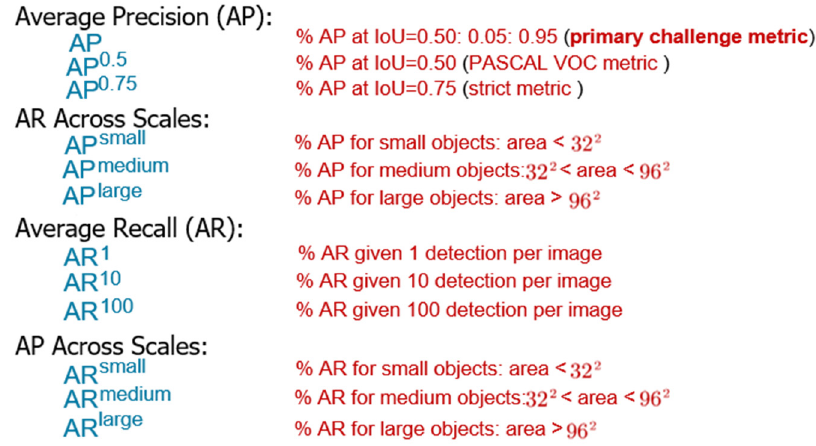
Figure 10. The detection evaluation metrics of COCO.